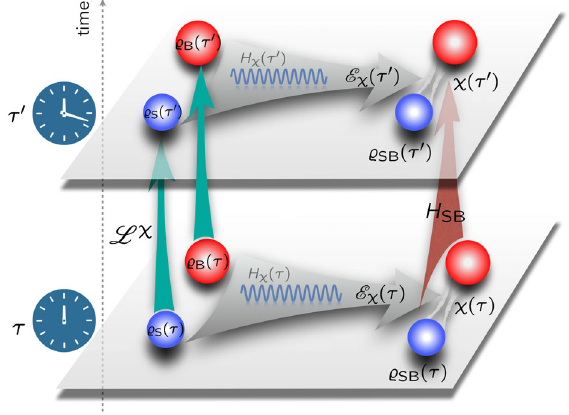
FIG. 1. Description of the correlation picture. At any time τ (or τ 0 ),acorrelatingtransformation E χ transformsanuncorrelatedstate ϱ ⊗ ϱ ϱ ϱ ⊗ ϱ χ , at the same S B to a correlated state SB ¼ S B þ instant of time, due to an abstract correlation-dependent parent operator given by H χ . Using this transformation, we obtain the temporal evolution of the uncorrelated system with a universal Lindblad-likegenerator L χ [seeEq.(9)]constructedfrom H SB ,the generator of the total system dynamics in the Schrödinger